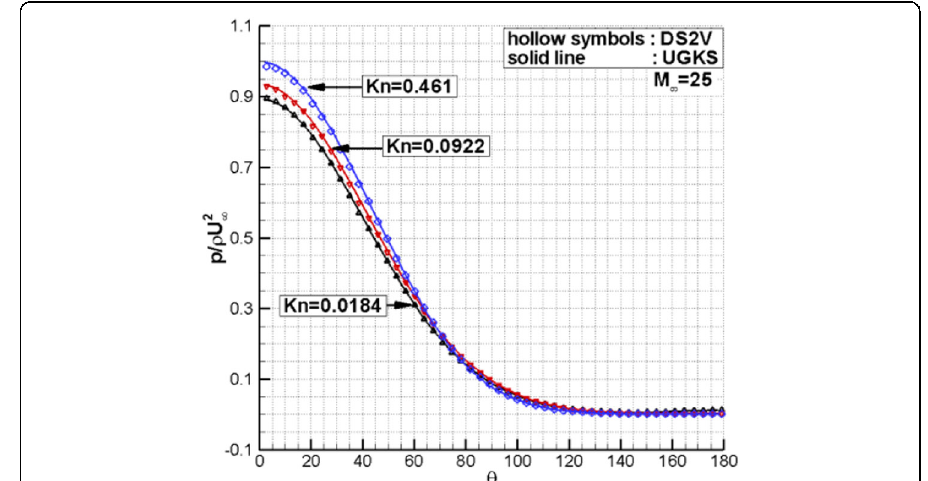
Fig. 20 Pressure distributions on the cylinder surface at M =